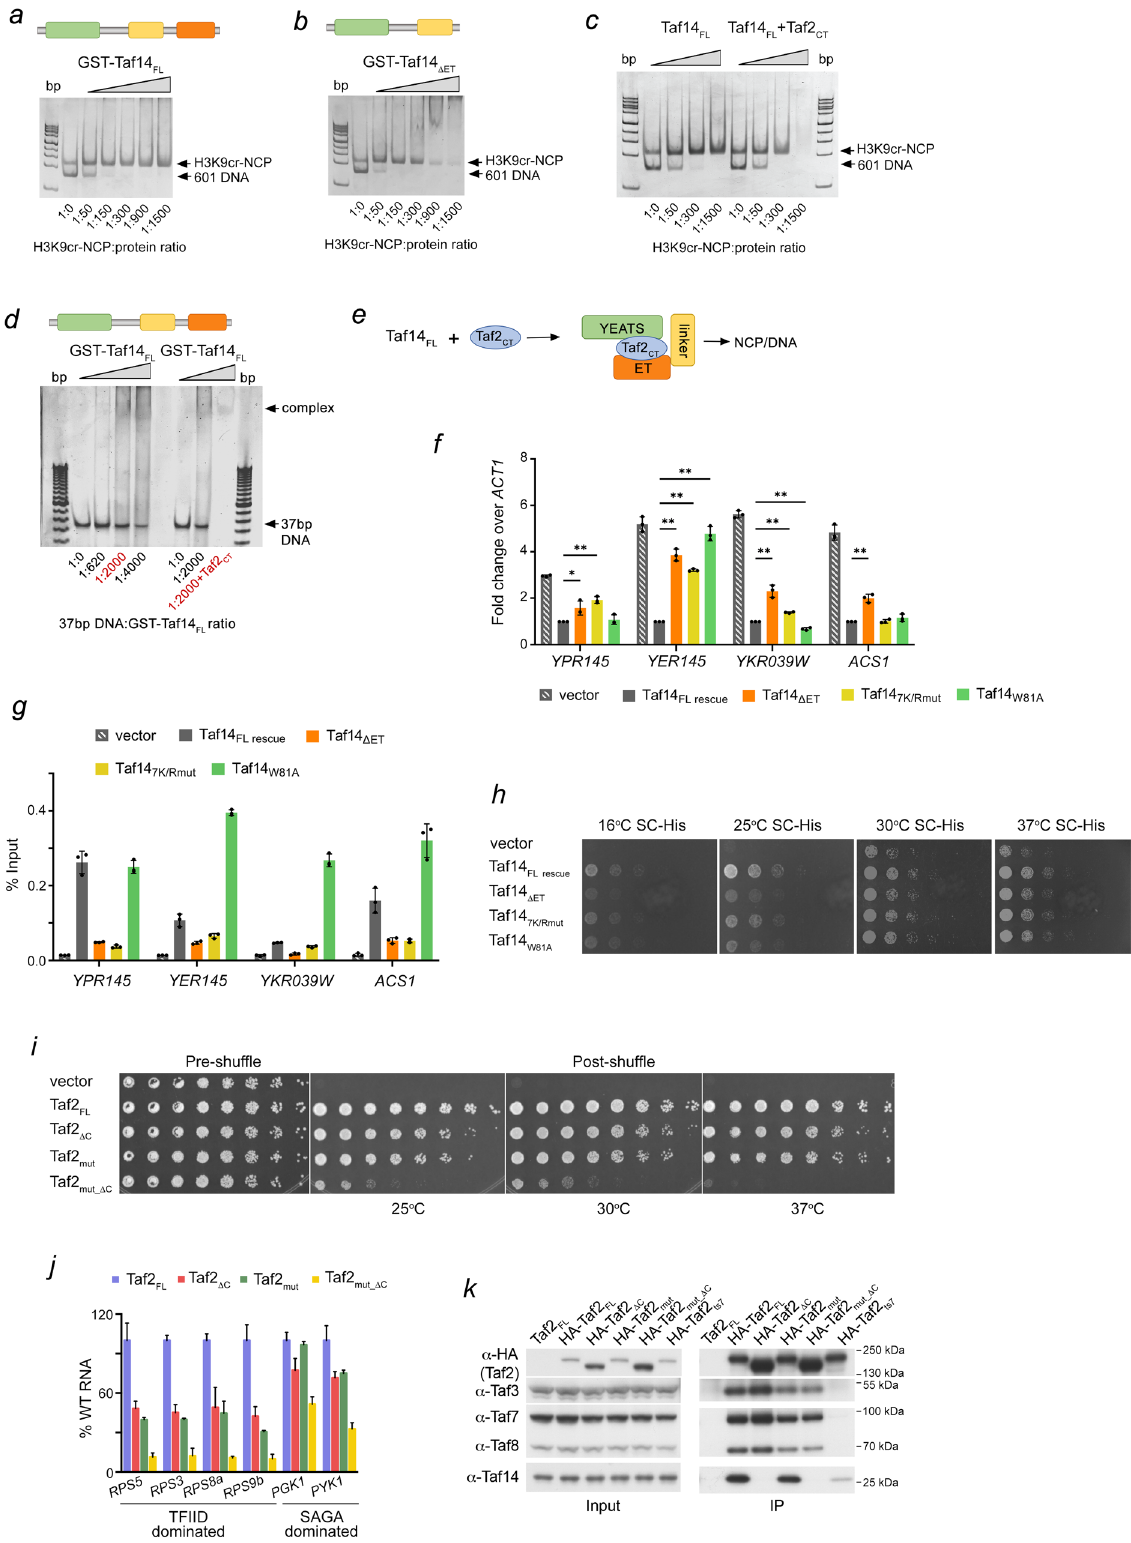
with SYBR Gold (Thermo Fisher Sci) and visualized by Blue LED (UltraThin LED Illuminator-GelCompany). NMR experiments . Nuclear magnetic resonance (NMR) experiments were per- formed at 298 K on Varian INOVA 900 MHz and 600 MHz spectrometers equipped with cryogenic probes. The NMR samples contained 0.1 –